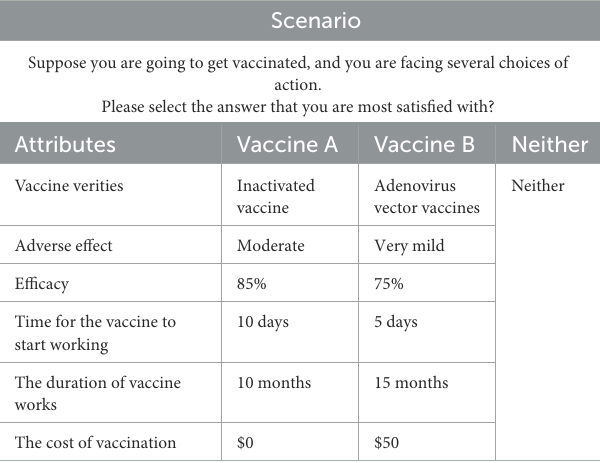
TABLE 1 Vaccine attributes and their respective levels in this discrete choice experiment.